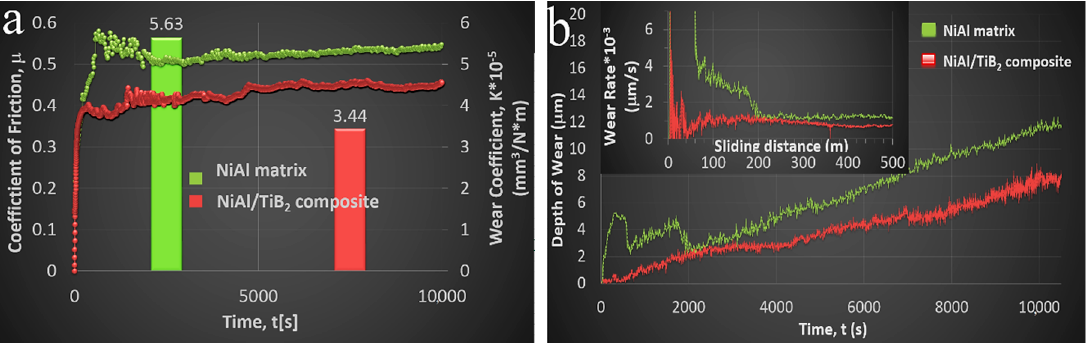
Figure 11. The course of the relationship between: ( a ) coefficient of friction and wear coefficient, ( b ) depth of scar and rate of wear as a function of the ball-on-disc process duration and sliding distance, respectively, observed in the manufactured sinters.